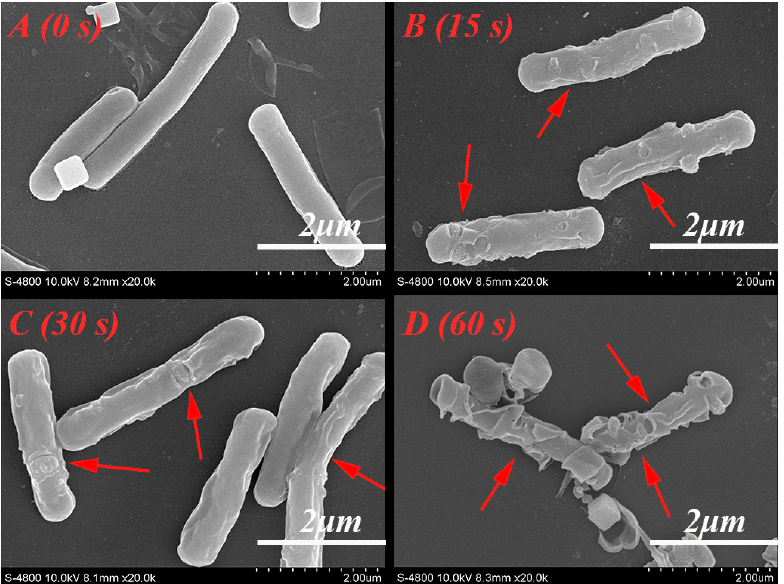
Figure 4. SEM images of ( A ) untreated A. acidoterrestris and ( B – D ) A. acidoterrestris treated by cold plasma for 15, 30 and 60 s, respectively, with a voltage of 1.32 kV and a gas flow rate of 130 mL/min. The red arrows indicate severe damage points on the cells. The magnification is ×20,000.